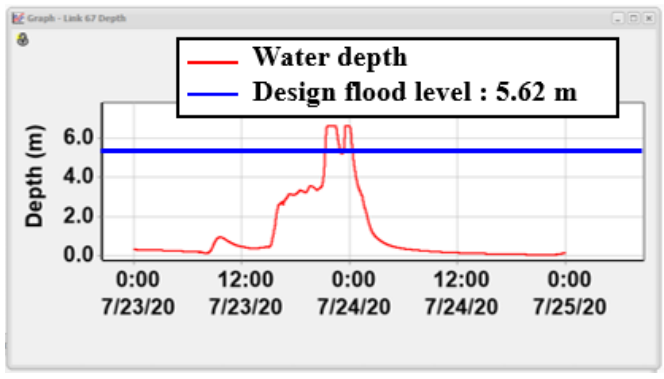
Figure 8. Station 2 simulation results for SWMM Model Validation.